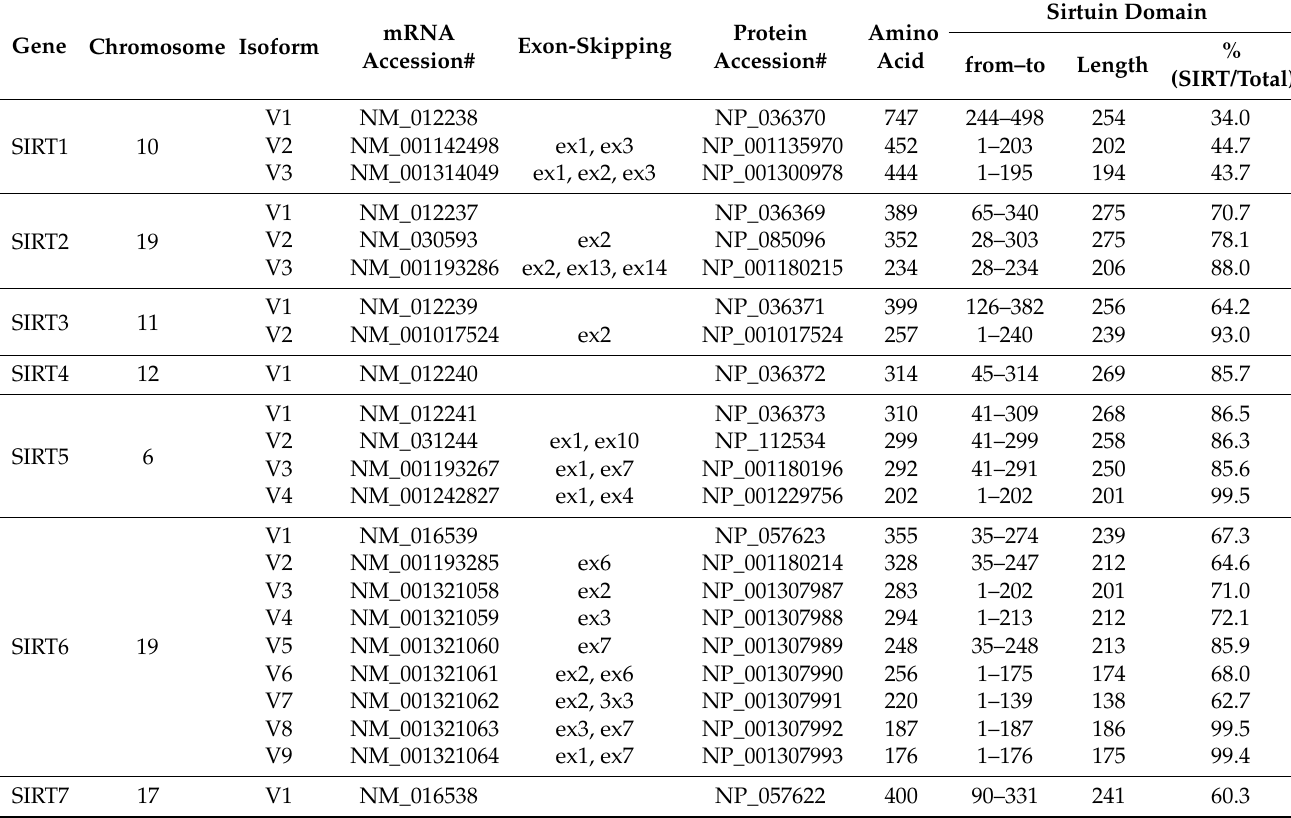
Table 1. A summary of 23 human sirtuin isoform mRNAs and proteins and their Genbank accession number. Alternative splicing resulted in the loss of part of the sequence and shortened the length of the sirtuin domain of most of the isoforms.